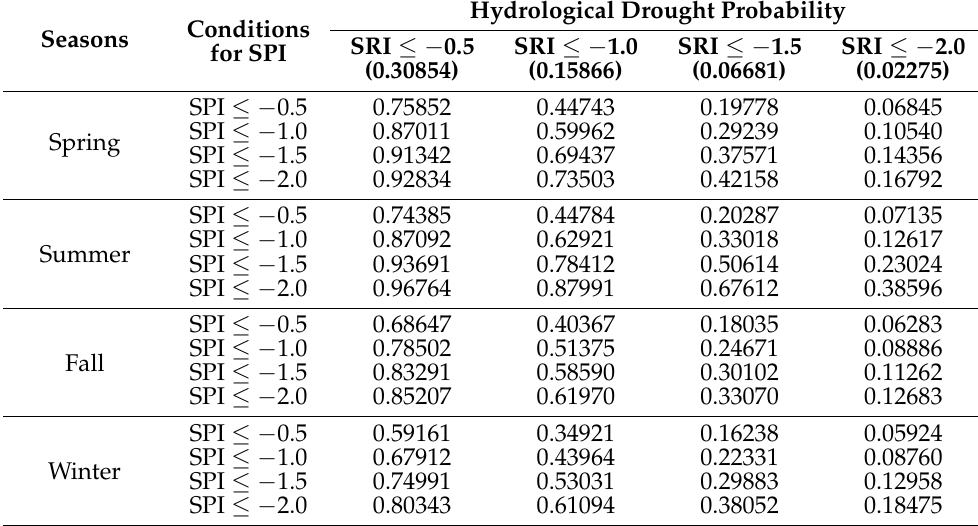
Table 6. Propagation probability of hydrological drought under various seventies of meteorological drought at Hapcheon Dam